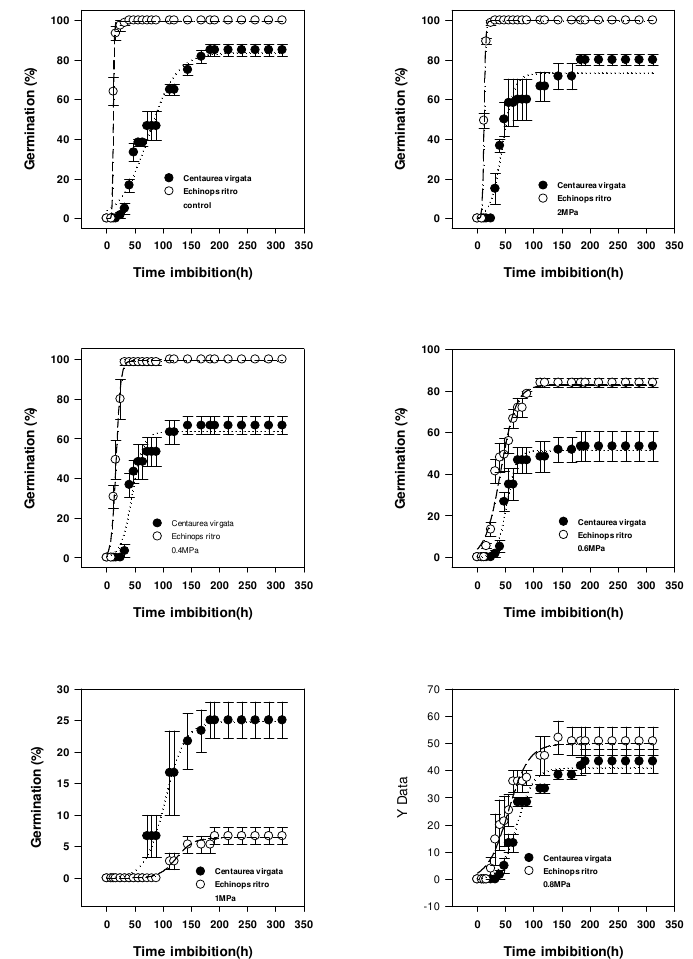
Figure 3. Seed germination rate of two weed species affected by drought stress treatments